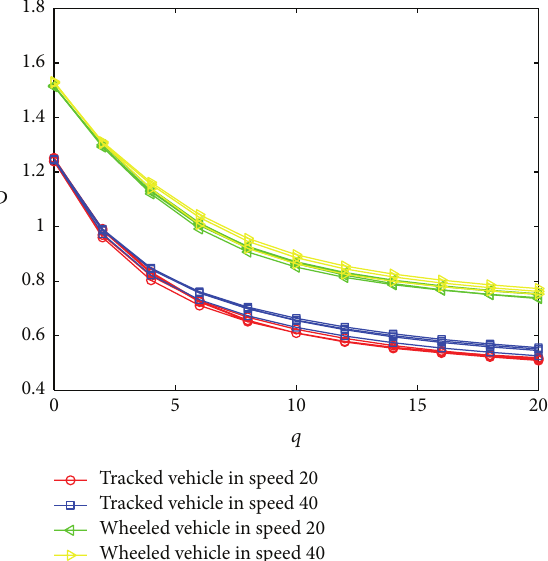
Figure 2: GFD of tracked vehicle and wheeled vehicle.